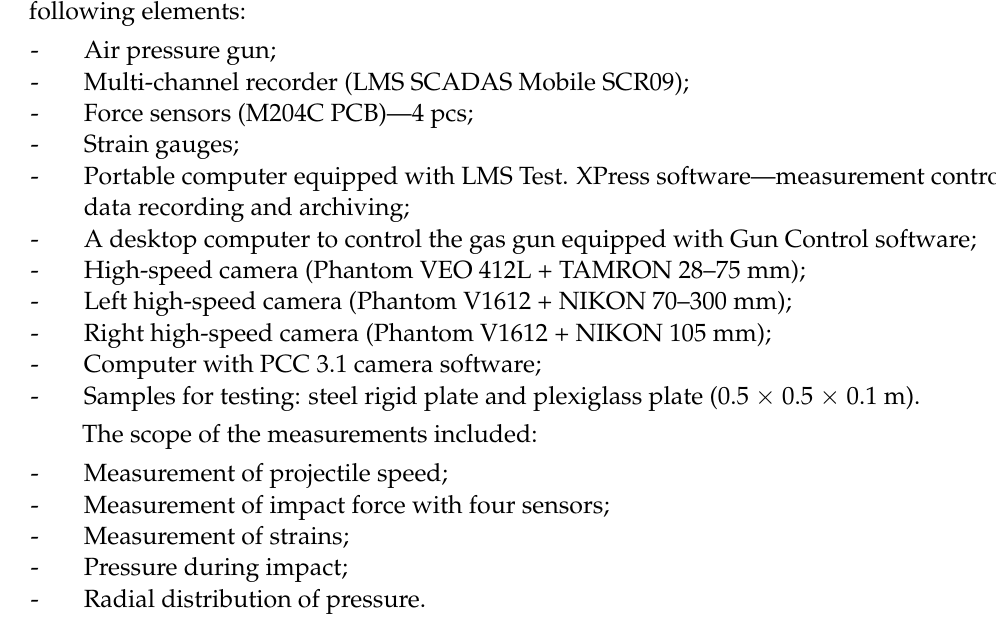
Figure 6. Gas gun DPZ-250. The projectile, placed in the sabot, is loaded in the rear of the barrel. The task of the muzzle device is to remove the sabot in such a way as not to disturb the trajectory of the projectile. On the opposite side of the barrel of the gas gun, a test bench is clamped to the floor to which the test samples are fixed. Ten shots were fired during the experimental tests. Shots no. 4 and 9 have been cho- sen for the presented analyses. The projectiles were made on the basis of NASA regulation TN-2015-218340. Depending on the weight, the projectiles had the following dimensions: diameter—106 mm, length—212 mm; weight 1.81 kg (Figure 7a). For each shot, a sabot made from styrodur xps with an external diameter of 250 mm was prepared. Before each shot, the sabot and the gelatin projectile (Figure 7b) were weighed. In this study, the pro- jectile velocity was 116 m/s (± 5 m/s).